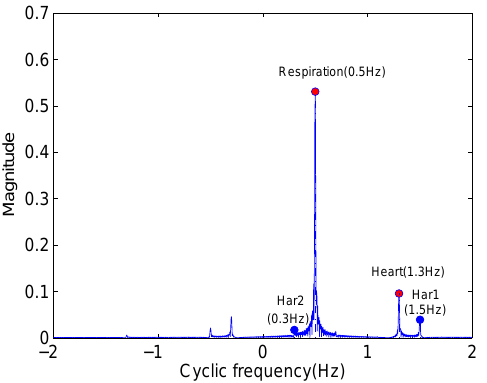
Figure 3. TOCC of Hilbert transform of B ( t ) with the same parameters with the ones in Figure